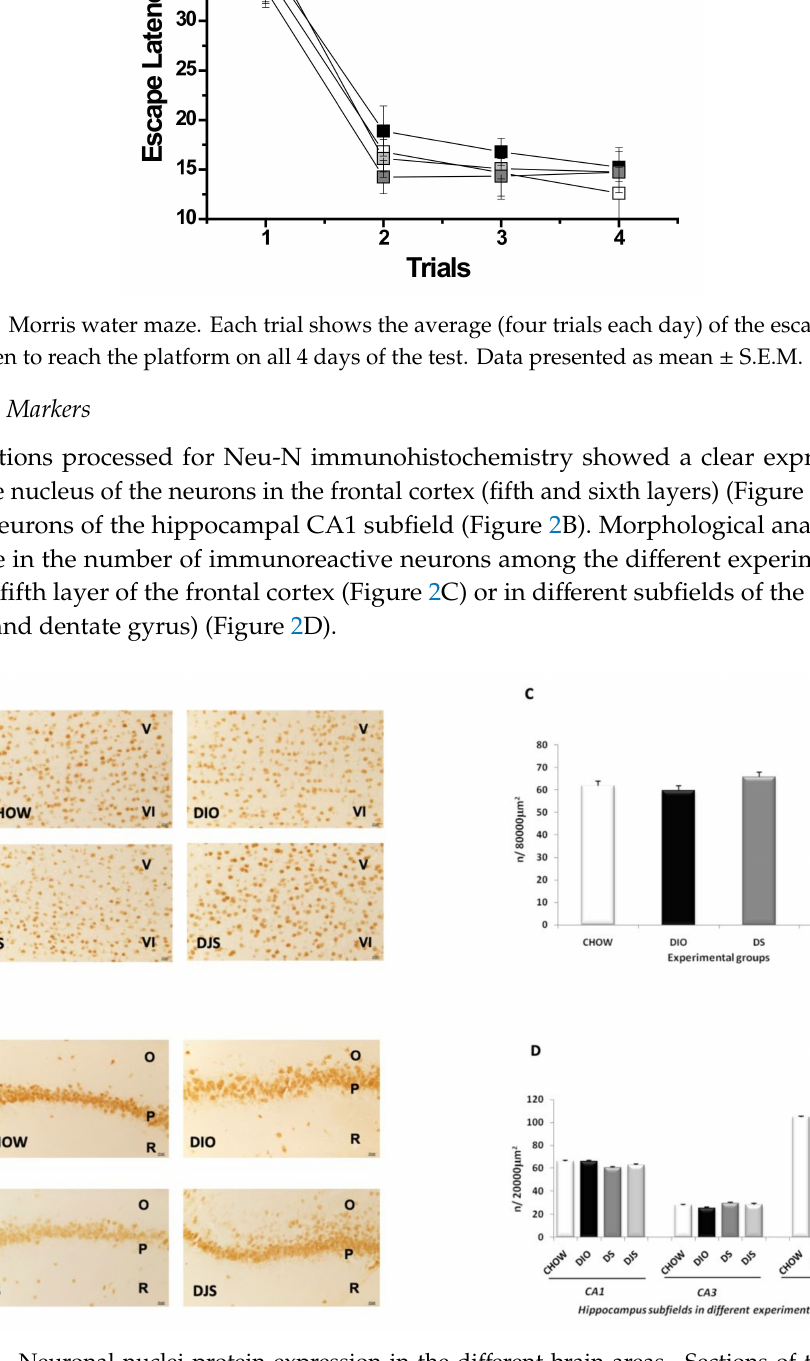
Figure 2. Neuronal nuclei protein expression in the di ff erent brain areas. Sections of the frontal cortex, V-VI layers ( A ), and the CA1 subfield of the hippocampus ( B ) were processed for Neu-N immunohistochemistry in the di ff erent experimental groups. O, stratum oriens ; P, pyramidal neurons; R, stratum radiatum . Calibration bar: 25 µ m. Morphometric analysis of a number of pyramidal neurons in the fifth layer of the frontal cortex ( C ) and the di ff erent subfields of the hippocampus ( D ) was performed in sections processed for Neu-N immunohistochemistry. Data are the mean ±